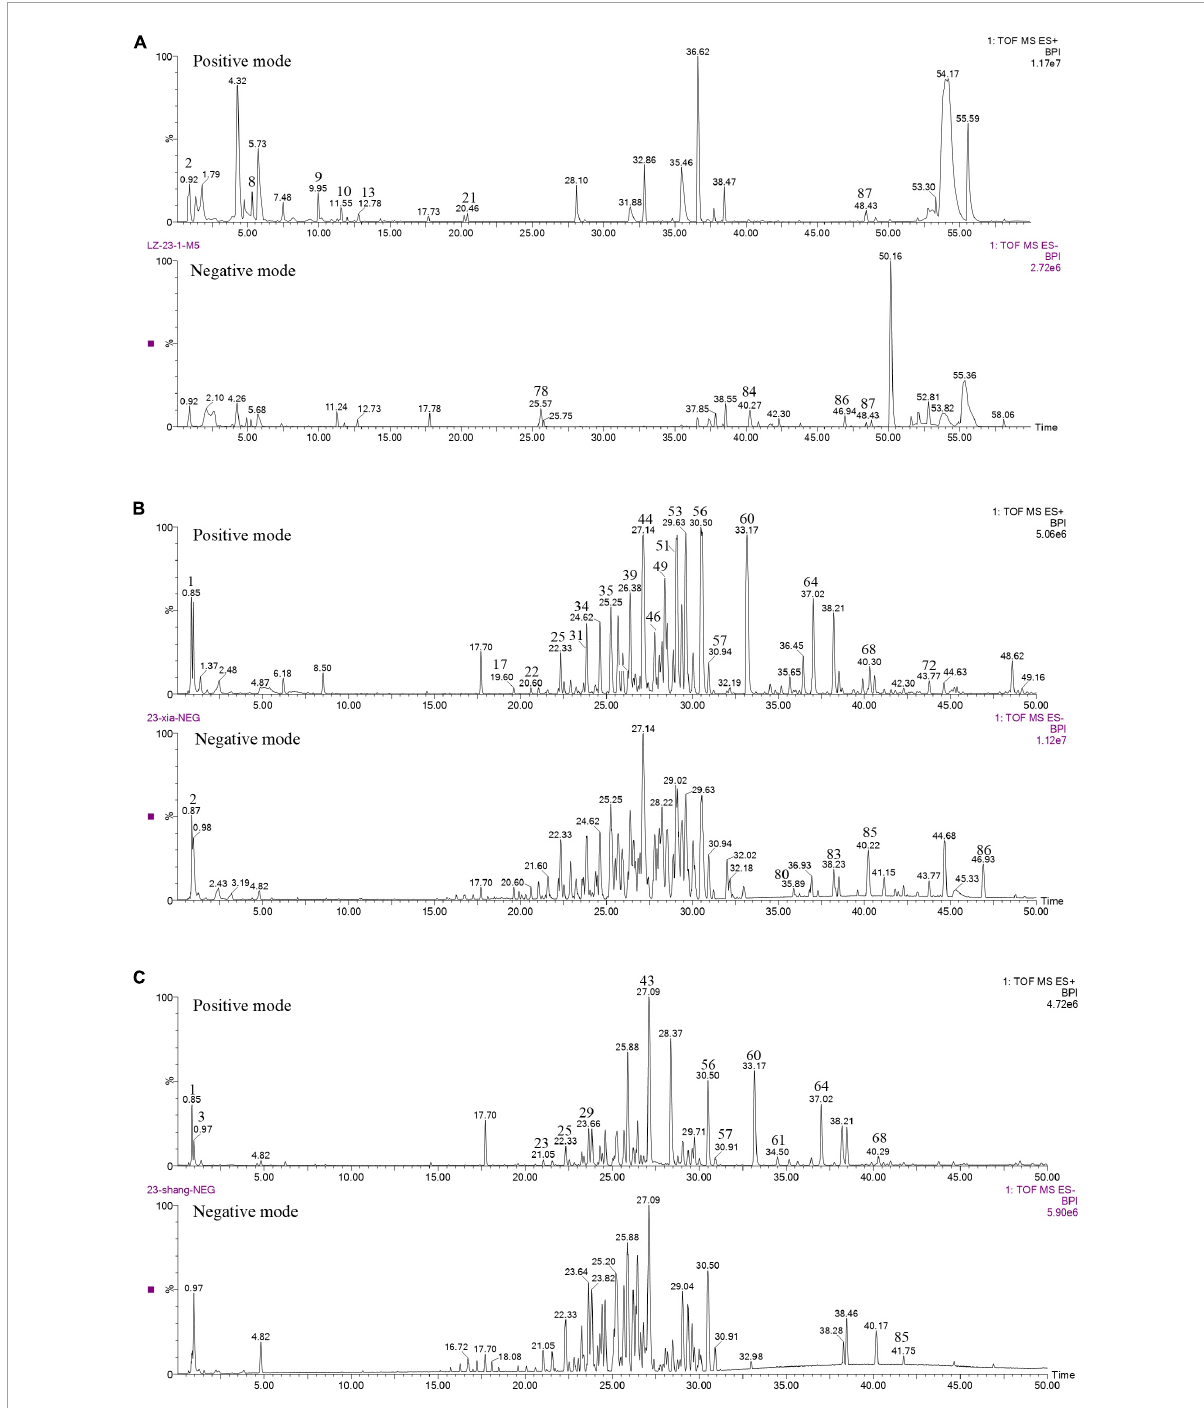
FIGURE1 Chemical analysis of G. lucidum in different growth periods. (A) Aerial mycelia, (B) primordium, (C) fruiting